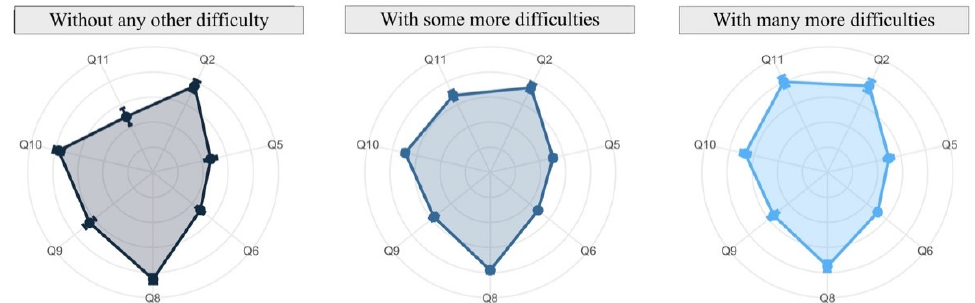
Figure 17. Reconciliation of virtual teaching activity with personal life compared to reconciliation in standard conditions (answers to Q3) related to the other aspects.